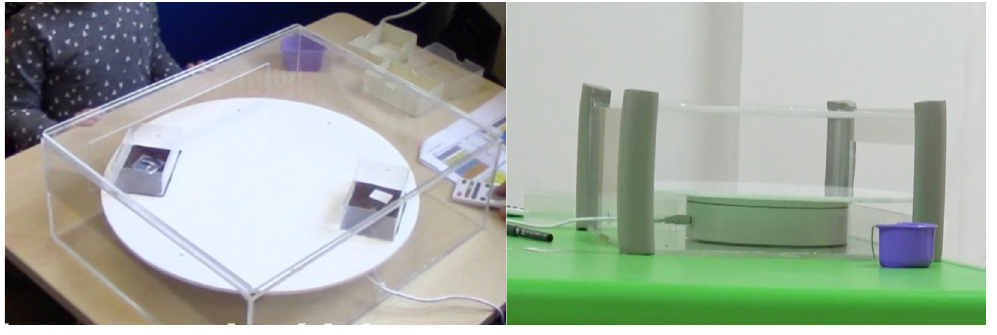
Fig 1. Rotating tray with two